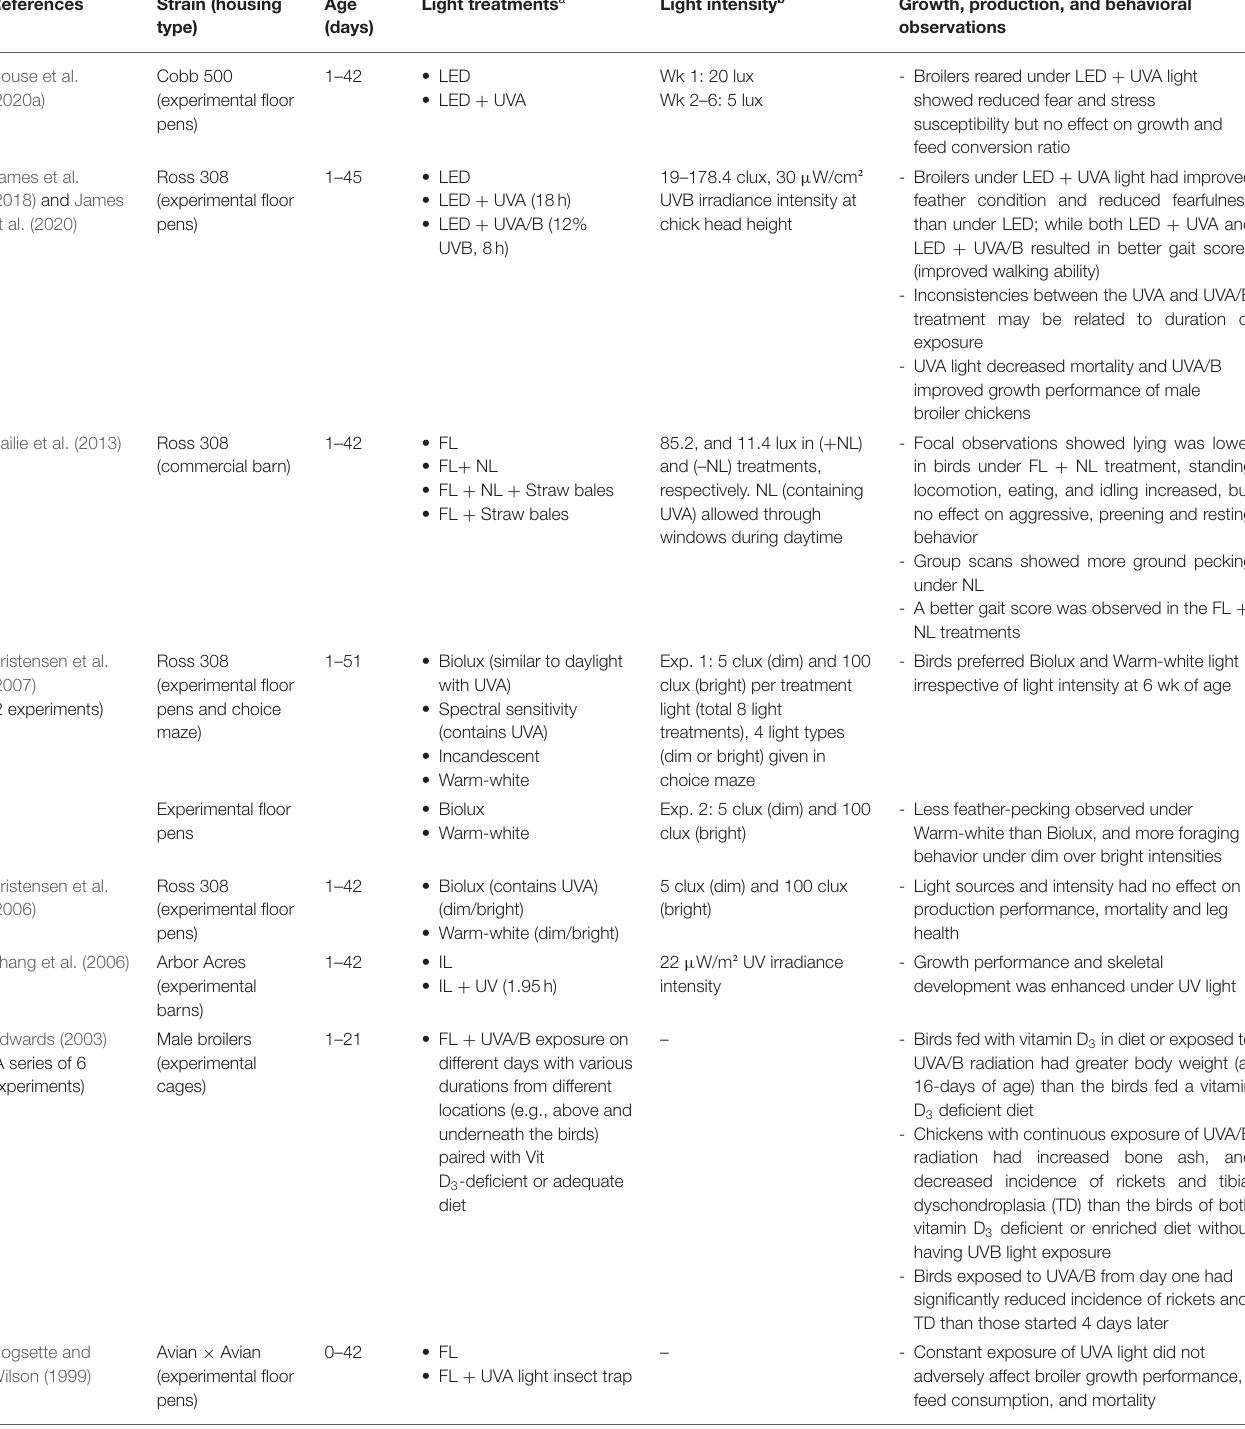
TABLE 4 | Effects of UV light on behavior, growth, and production of meat